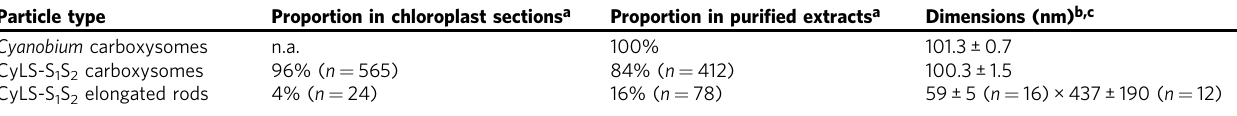
a Proportions in each particletype in chloroplastsections and puri fi ed extracts were determined from analysisof TEMimages. Elongatedrods were de fi ned as structures withaverage widths <75nm and disproportionate length b Carboxysome dimensions were determined as the mode (±s.e.m.) of particle distributions measured using a Nanosight NS300 from 12 analyses of two independent preparations of Cyanobium carboxysomes and 19 analyses of three independent preparations of CyLS-S 1 S 2 carboxysomes c Elongated rod dimensions were determined as mean widths and lengths (±s.d.) of particles analysed in TEM images of puri fi ed carboxysome preparations from CyLS-S 1 S 2 leaves. Note that there is a greater proportion of elongated particles observed in puri fi ed extracts, which we assumeto be due to a combinationof: breakage of very long particles during isolation, giving rise to a greater proportion of rods and, dif fi culty in accurately identifying elongated carboxysomes in random cross-sections of chloroplasts. n.a. not